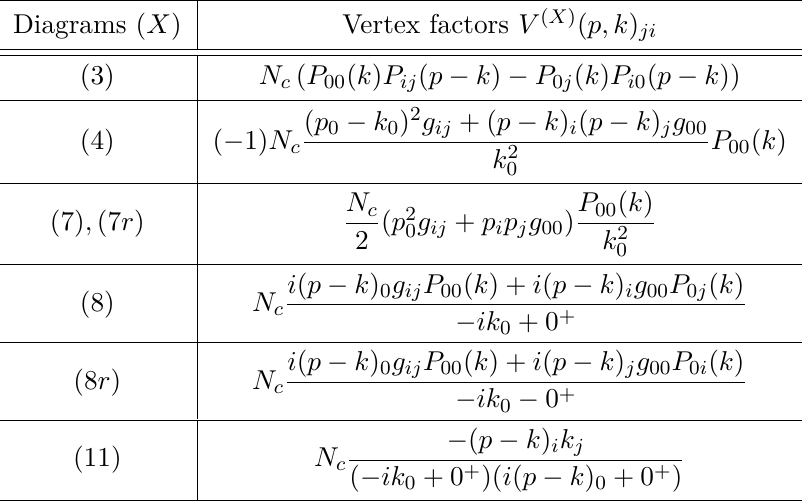
(cid:2) (cid:3) da g ++ E ji,JI